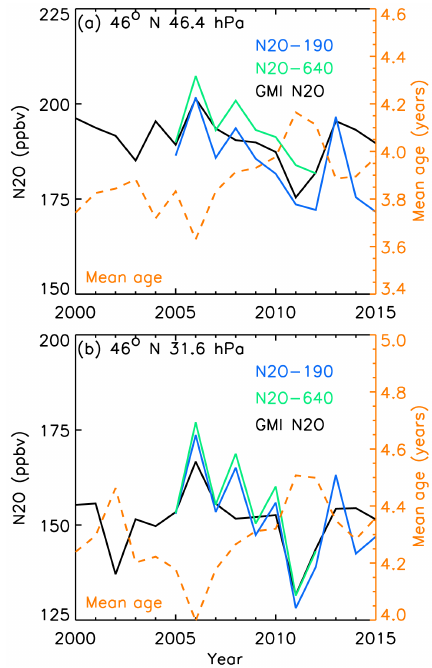
Figure 8. The 46 ◦ N annual zonal mean N 2 O in the GMI CTM (black), the MLS N 2 O-640 (green), the MLS N 2 O-190 (blue) and the mean age (orange dashed) at (a) 46.4hPa and (b) 31.6hPa. The simulated N 2 O tracks the observed values and is anticorrelated with the mean age at both levels ( − 0.86 and − 0.83 at 46.4 and 31.6hPa,